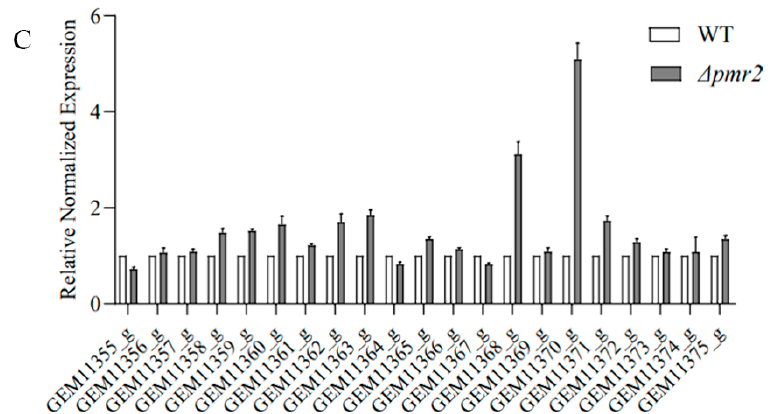
Figure 5. Pmr1 and Pmr2 negatively regulate the production of secondary metabolites. ( A ) HPLC analysis on the production of secondary metabolites in WT, Δ pmr1 and Δ pmr2 mutants. The analysis was repeated for three times. ( B ) RT-qPCR analysis of genes in dibenzodioxocinons biosynthesis gene cluster in Δ pmr1 strain grown in PLB for 8 days. The expression data were analyzed by the GraphPad 8. ( C ) RT-qPCR analysis on the expression levels of genes in dibenzodioxocinons biosyn- thesis gene cluster in Δ pmr2 strain cultivated in PLB for 8 days.